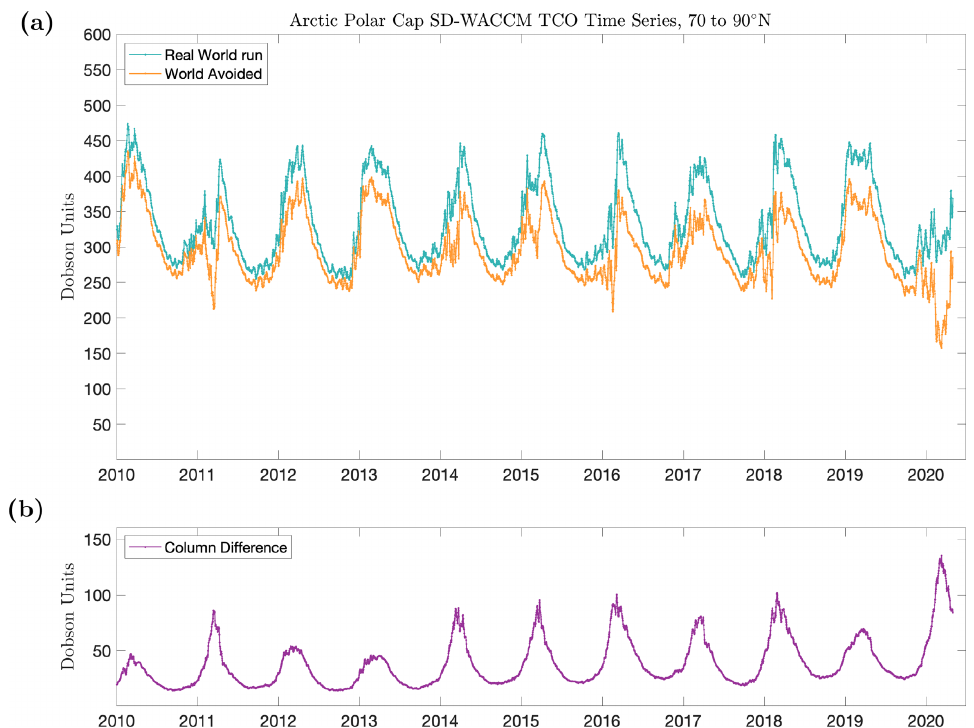
Figure 7. (a) Time series of mean SD-WACCM total column ozone across the polar cap for the RW scenario (teal) and WA scenario (orange) from January 2010 through April 2020. (b) The difference between the